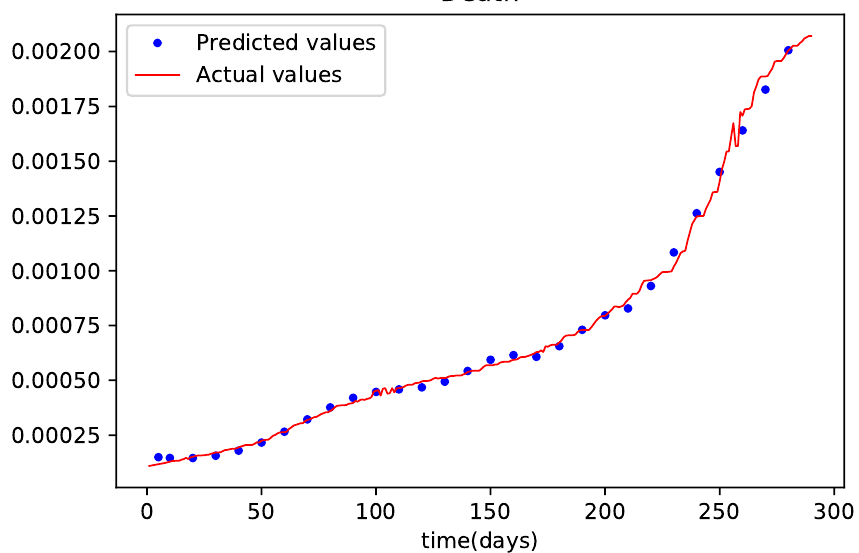
Figure 10. The graph shows a comparison of the predicted deceased population values and the actual data deceased population for the State of